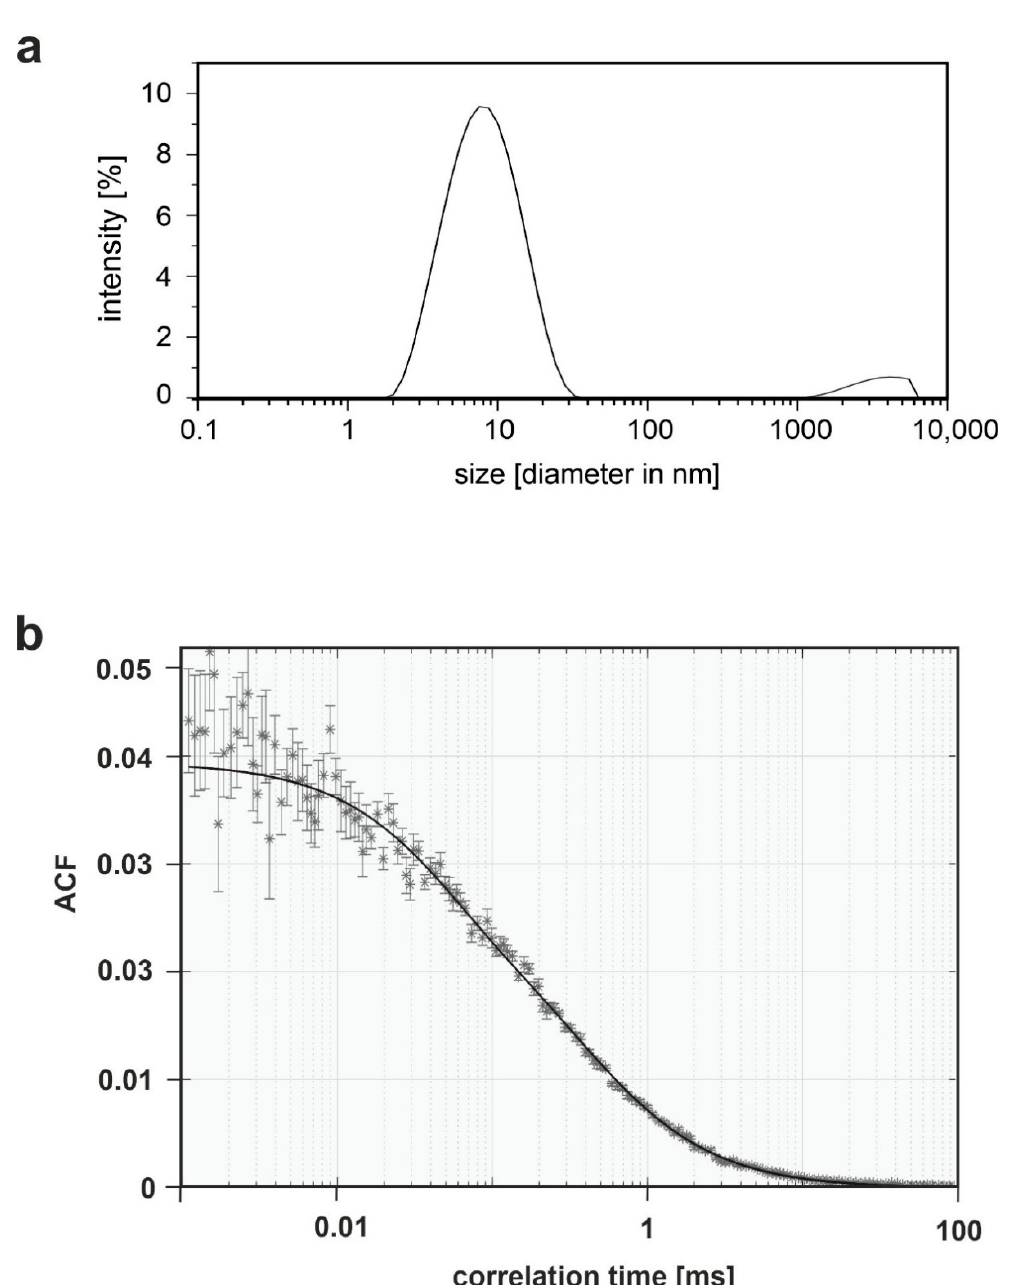
Figure 3. Quality assessment of crude SMALP preparations. ( a ) Representative image of size distribution of a SMALP preparation after membrane solubilization based on dynamic light scattering (DLS) data. ( b ) Representative example of a Fluorescence Correlation Spectroscopy (FCS) analysis. The curve was fitted by a model considering triplet-state blinking (black line). Calculations given in the text were based on at least three such curves obtained for four different SMALP preparations, each, which displayed similar kinetics. ACF = autocorrelation function.